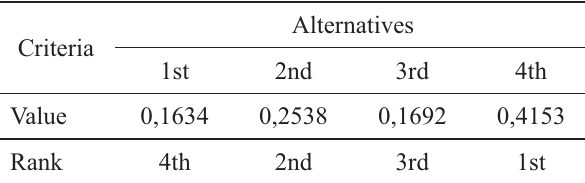
Table 3. The data obtained in multicriteria evaluation of the considered object’s alternatives by SAW method Criteria